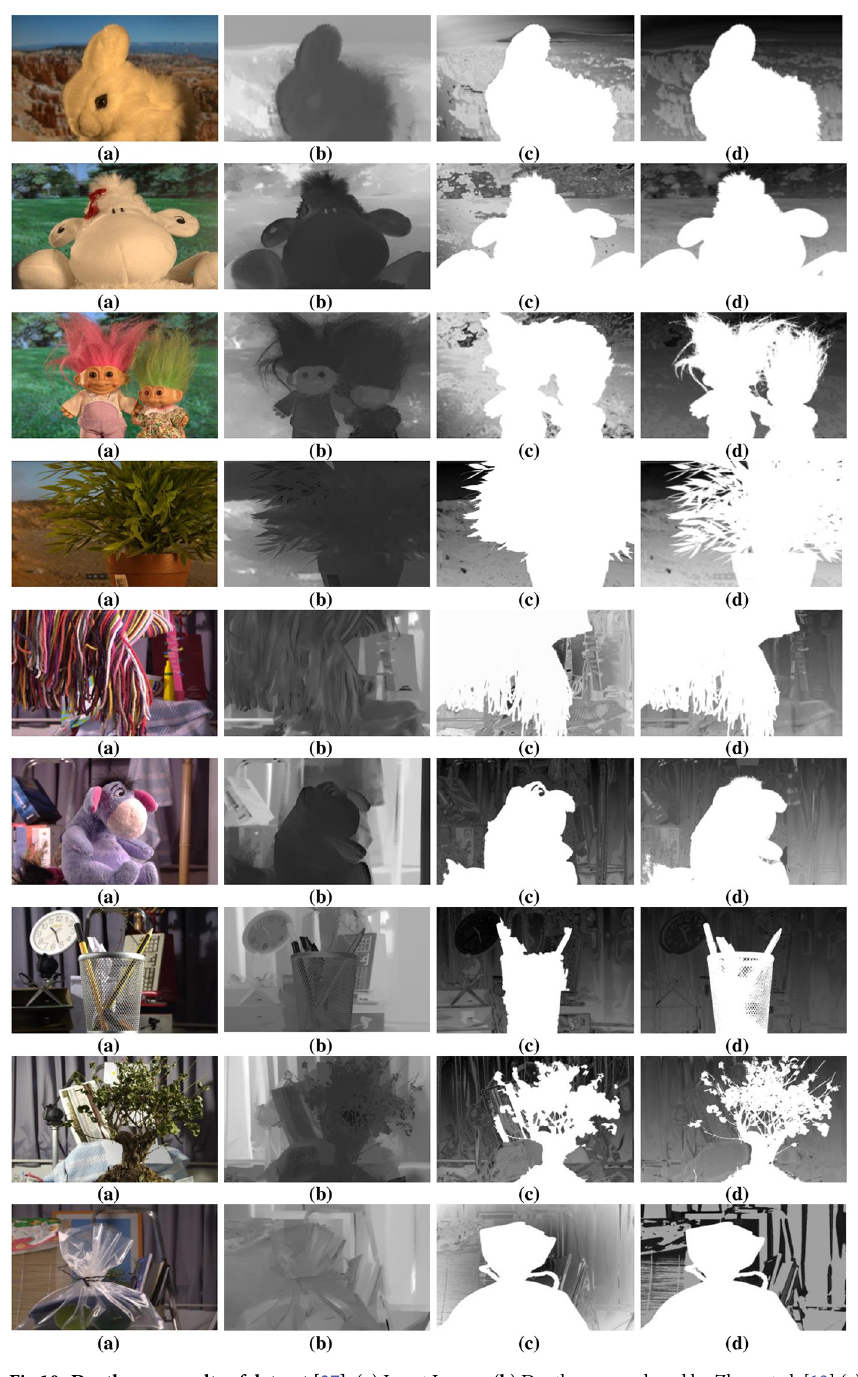
Fig 10. Depth map results of dataset [37]. ( a ) Input Images ( b ) Depthmap produced by Zhuo.et al. [12] ( c ) Depthmap produced by Yang.et.al. [26] and ( d ) Depth-map generated by DFB-DIBR.